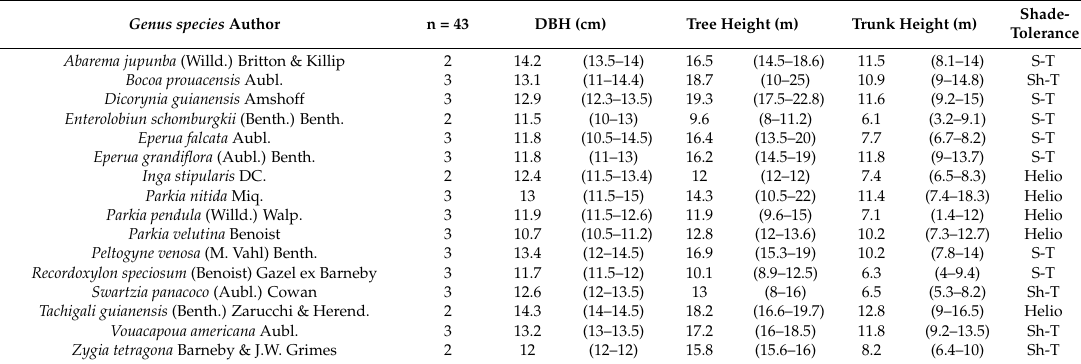
Table 1. General information on the species and individuals